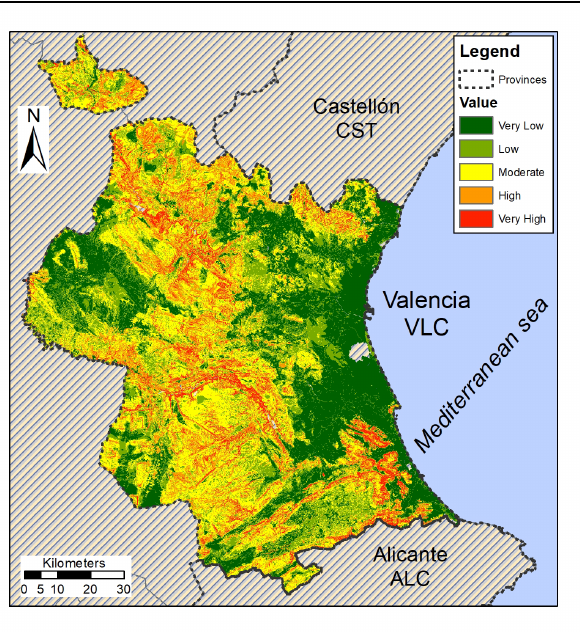
Figure 5. Example of a susceptibility map for the province of Valencia (RFR with GY classification).